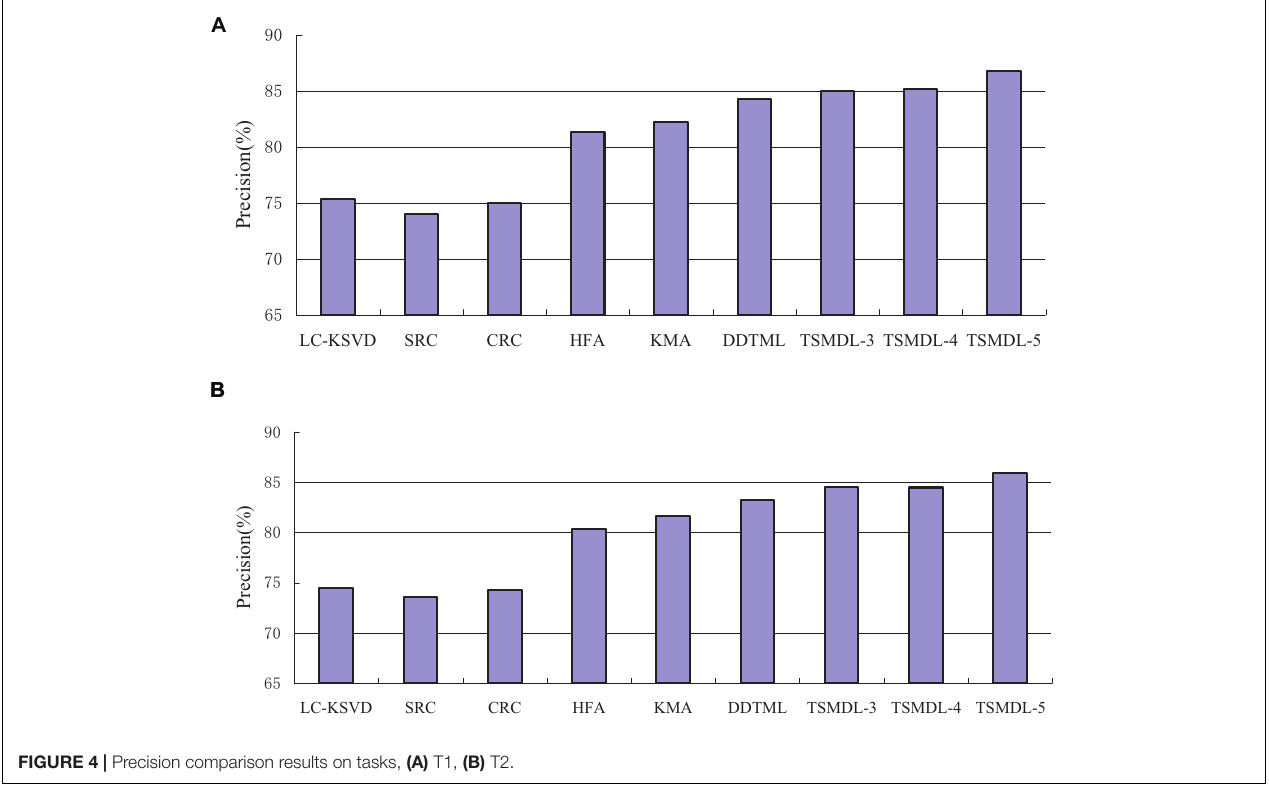
FIGURE 4 | Precision comparison results on tasks, (A) T1, (B) T2.